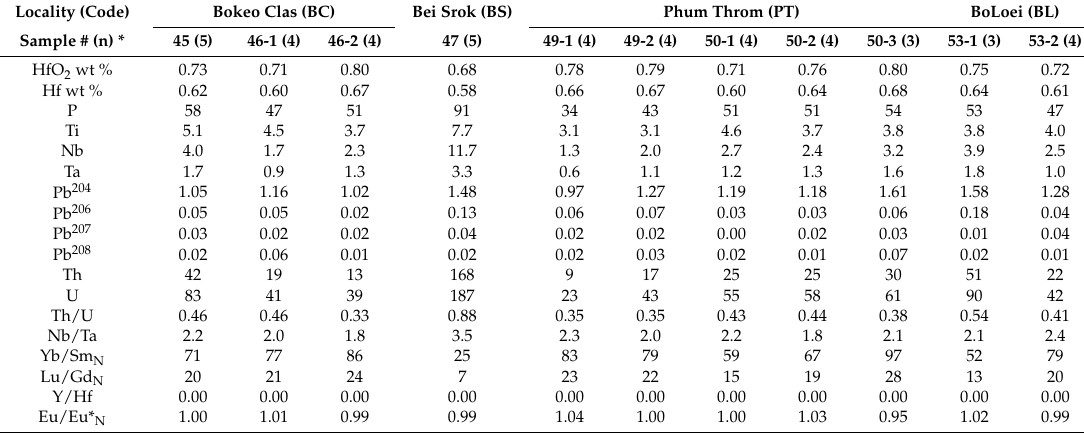
Table 2. Average trace element composition, ratios, and sums (ppm) of RVP zircon